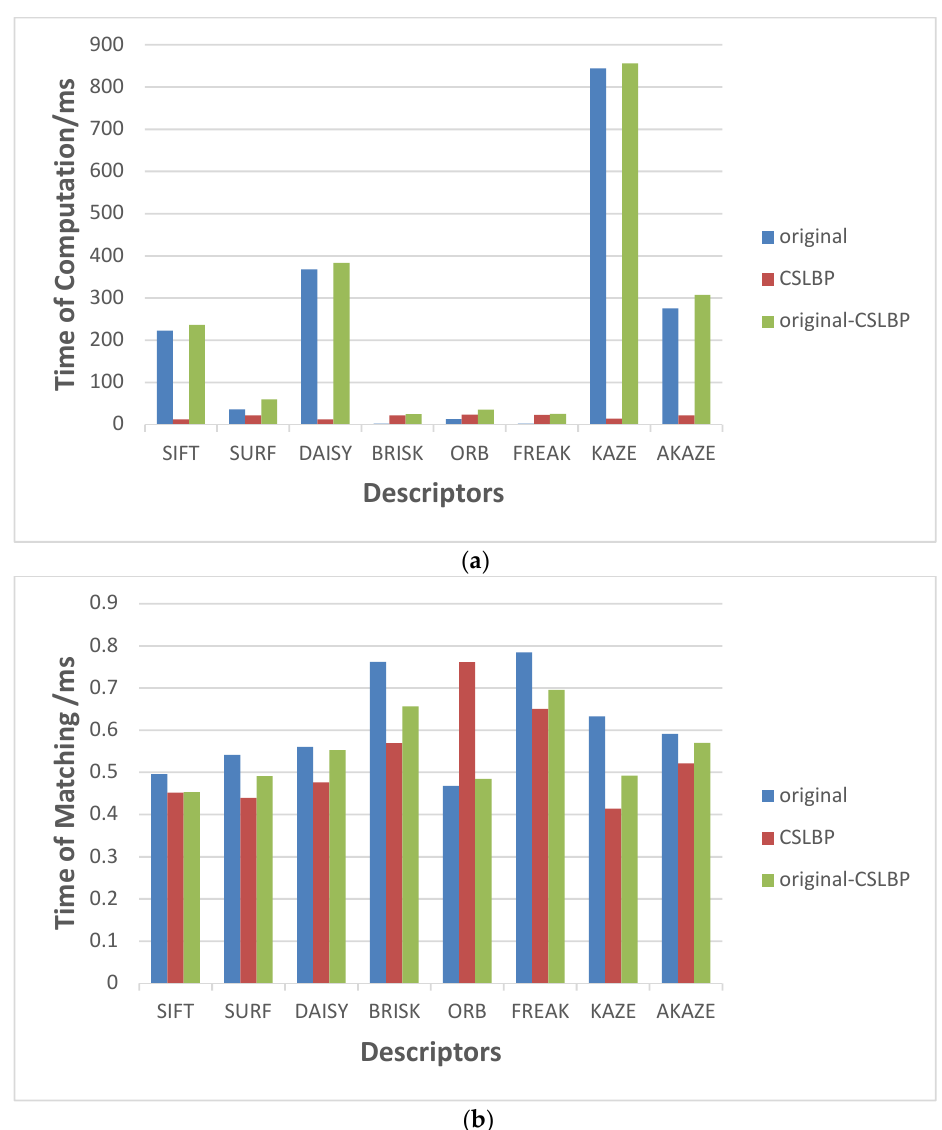
Figure 19. Comparison results of computational and matching time consumption for the eight original, the CSLBP and the improved descriptors. The blue histograms represent the time consumption of the original descriptors, the red histograms denote the time consumption of the CSLBP descriptors and the green histograms indicate the time consumption of the improved descriptors. ( a ) Computational time consumption of 30 descriptors; and ( b ) matching time consumption of 30 descriptors against 30